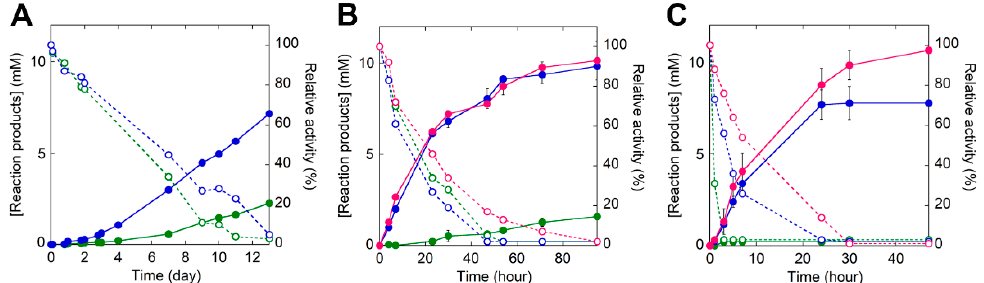
Figure 6. Biodegradation of PET microplastics by TS- Δ IsPET variant at ( A ) 30 °C, ( B ) 40 °C, and ( C ) 45 °C. The reaction was followed through the determination of the total amount of soluble reaction products in the supernatant of the reaction mixture (continuous line): Δ IsPET (green), TS variant (blue), and TS variant in the presence of 10% glycerol (red). The residual activity of the enzyme in solution is reported as dashed lines. Reaction conditions: 9 mg mL − 1 of microparticles and 0.1 mg mL − 1 of Δ IsPET variants in 50 mM sodium phosphate buffer, 100 mM NaCl, pH 8.0. Biodegradation kinetics were performed in triplicate.